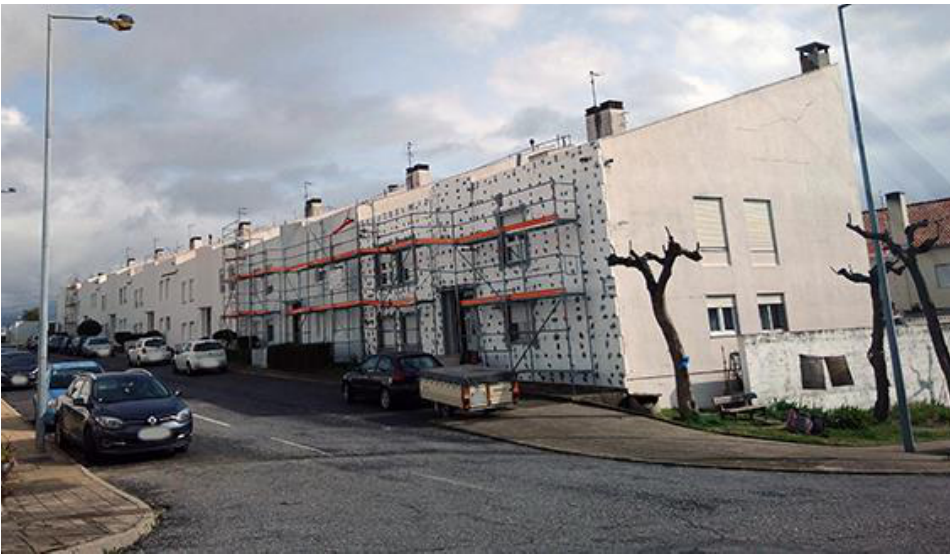
Figure 1. Retrofit intervention in a social housing neighborhood located in Covilhã.